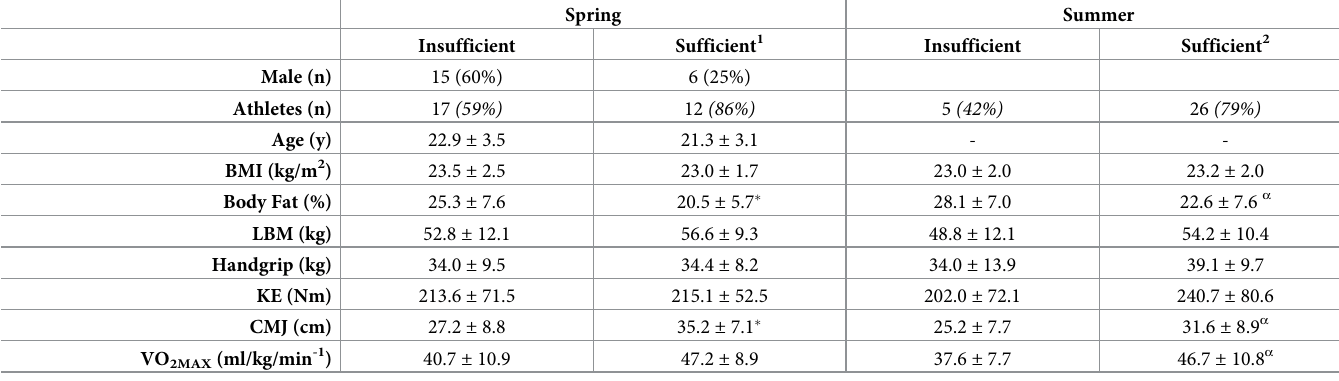
Table 2. Participant characteristics and physical performance parameters according to vitamin D status.